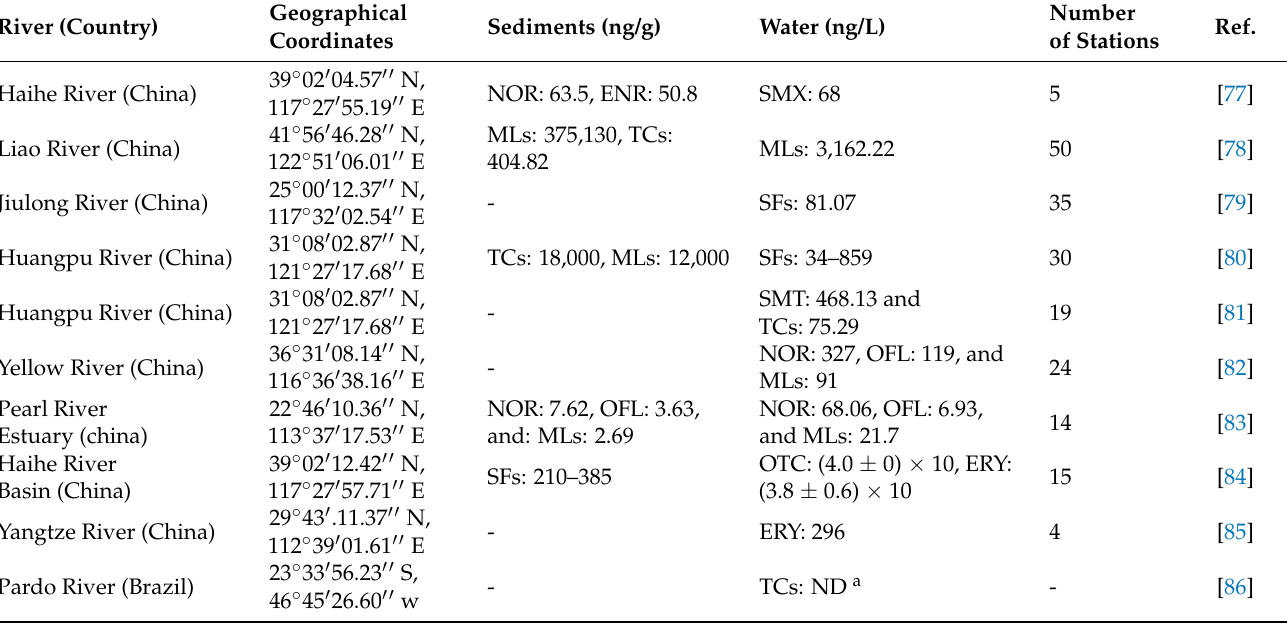
Table 3. Studies on antibiotics’ concentrations in the sediments and water of rivers around the